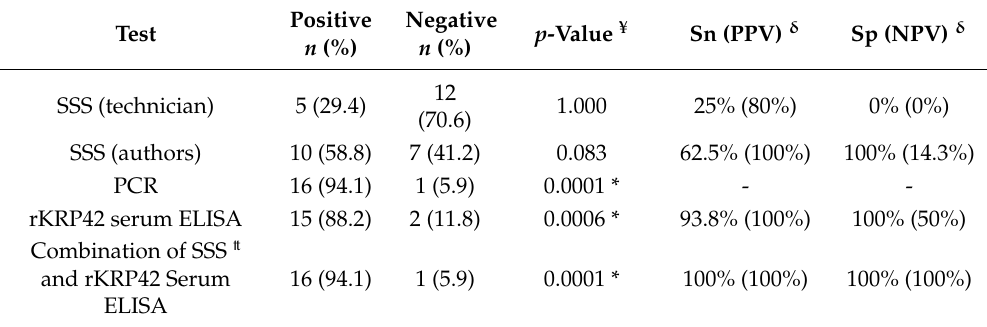
Table 4. Comparison of the diagnosis of clinically doubtful lesions ( n = 17) by different techniques.